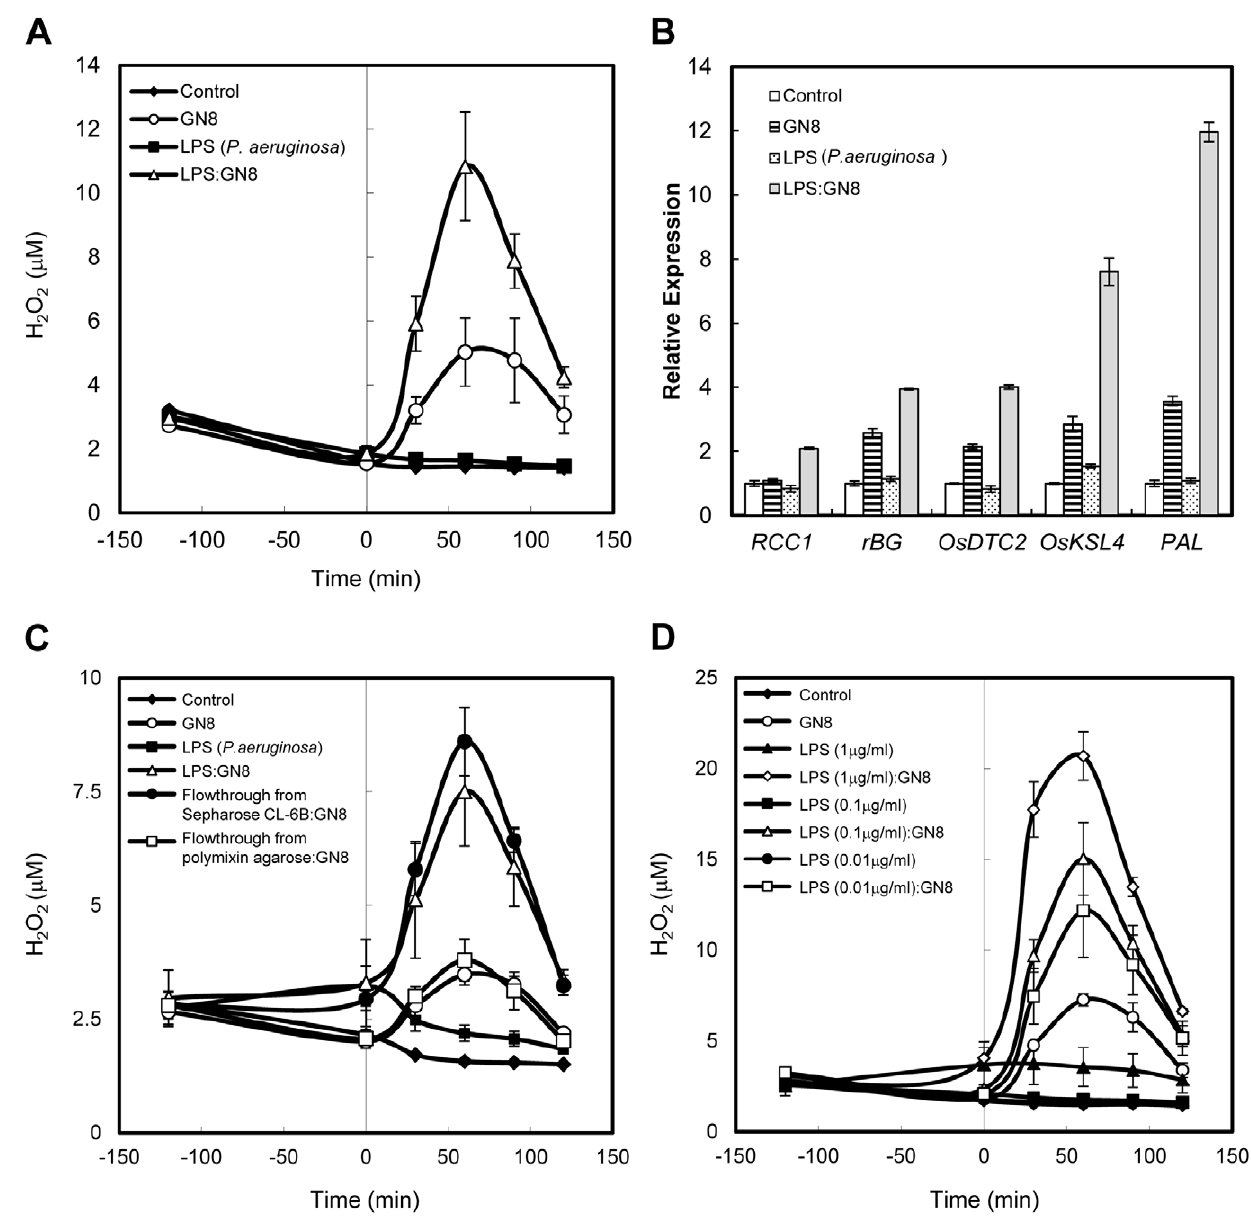
Figure 1. LPS pretreatment primed chitin-induced defense responses in rice cells. (A) Priming of GN8-induced ROS generation by the pretreatment with P. aeruginosa LPS. (B) Priming of GN8-induced expression of defense related genes by the pretreatment with P. aeruginosa LPS. Relative expression to the water control was shown. RCC1 (AK061042), rice class 1 chitinase; rBG (AK058891), rice b 1,3-glucanase; OsDTC2 (AK108710), stemar-13-ene synthase; OsKSL4 (AK119327), 9 b H-pimara-7,15-diene synthase; PAL (AK068993), phenylalanine anmonia lyase. (C) Confirmation of LPS as the active component for priming activity. Commercial P. aeruginosa LPS preparation was applied to either a polymixin B-agarose column or a sepharose CL-6B column, and eluted with distilled water. Priming activity in the commercial LPS preparation was completely recovered in the flow- through fraction from the sepharose CL-6B column. On the other hand, the flow-through fraction from polymixin B-agarose column did not show detectable priming activity. (D) Dose dependency of priming activity of P. aeruginosa LPS on GN8-induced ROS production. LPS concentration